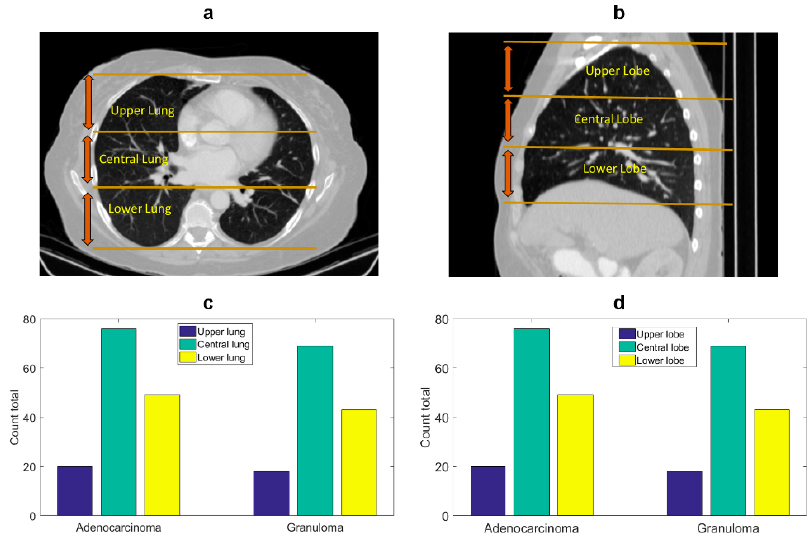
Figure A1. Association of nodule location and diagnostic class. Axial ( a ) and sagittal ( b ) plane CT images with each lung divided into upper, central and lower lung zone. Bar diagrams showing the distribution of the adenocarcinomas and granulomas based on their location in different zone on axial plane ( c ), and sagittal plane ( d ). Table A4. The p-values corresponding to the (cid:2031) (cid:2870) test between the diagnostic class of a nodule and its relative position in axial and sagittal planes. p -value<0.01 was indicating the presence of a sig- nificant association.